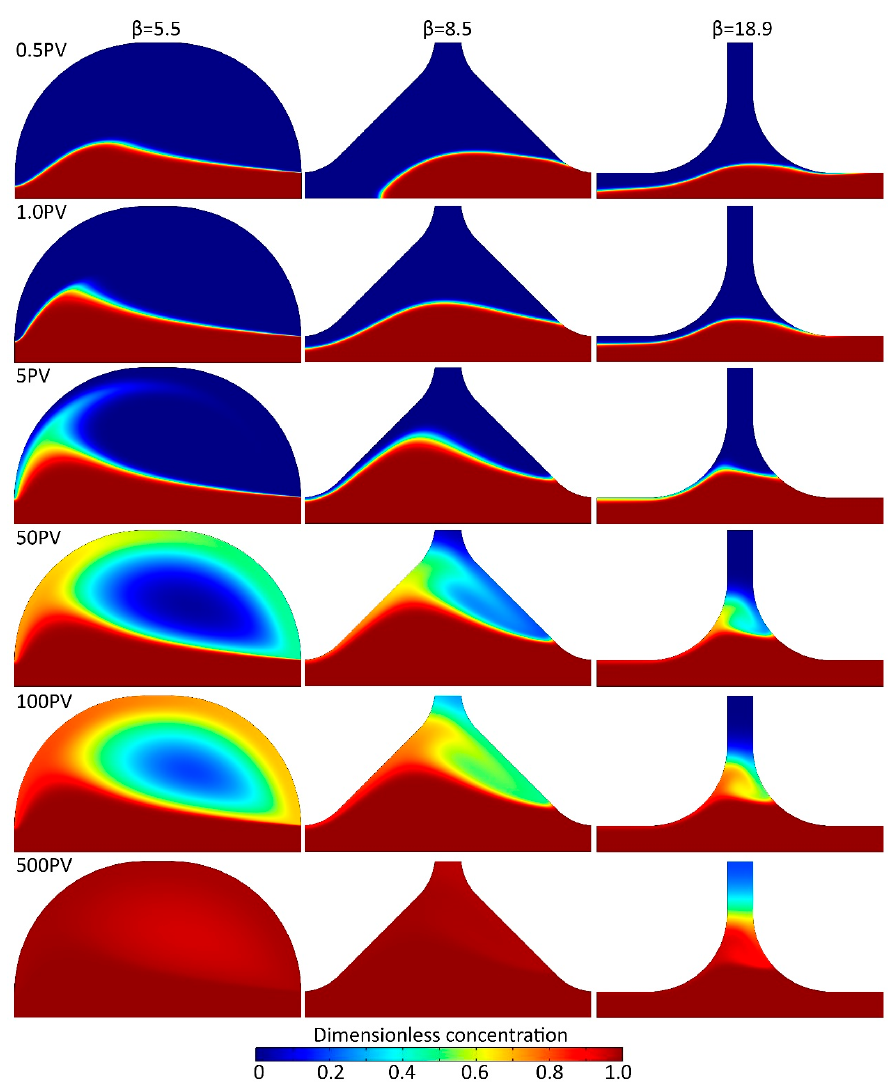
Figure 3. The snapshots of transport processes over time in different row for three pore geometries in different columns with β = 5.5, 8.5, and 18.9, where the color indicates the dimensionless concentration.